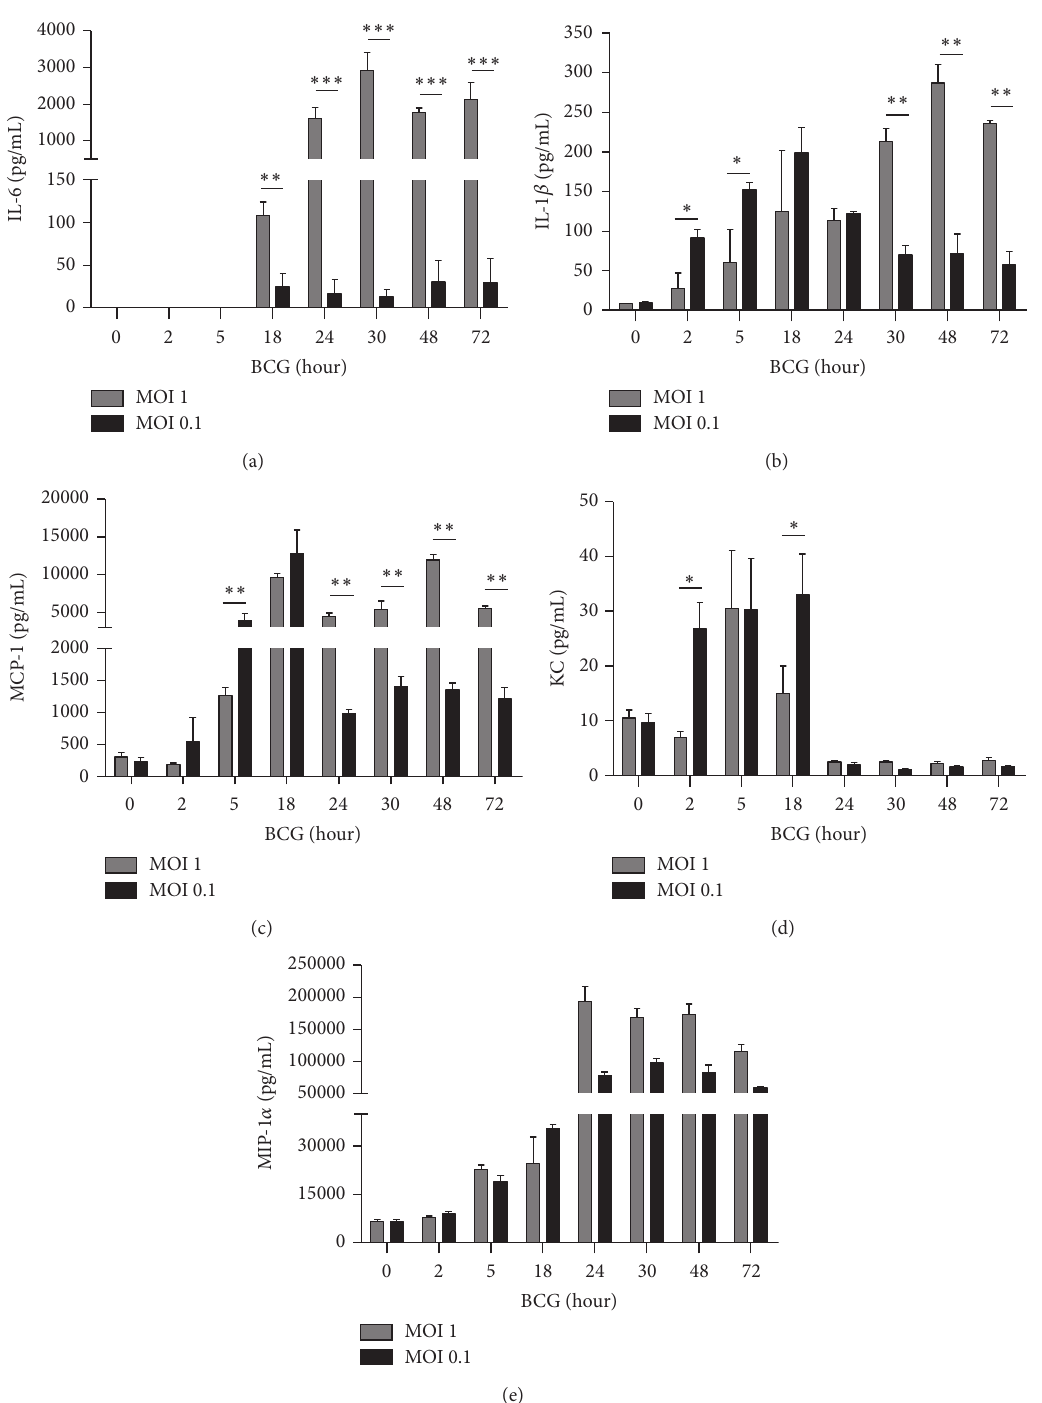
Figure 3: BCG infection at MOI 1 and MOI 0.1 is efficient to induce cellular activation but kinetics are different. (a) Concentrations of proinflammatory cytokines IL-6, (b) IL-1 𝛽 , and chemokines, (c) MCP-1, (d) KC, and (e) MIP-1 𝛼 , were measured by ELISA in culture supernatant from infected RAW macrophages with BCG Pasteur at MOI 1 and MOI 0.1 during different time points. Bars indicate mean ± SEM from four independent experiments. ANOVA and Dunnett’s post hoc test compared to uninfected macrophages or MOI 1 versus MOI 0.1. ∗∗∗ 𝑃 < 0.001 , ∗∗ 𝑃 < 0.01 , and ∗ 𝑃 < 0.05